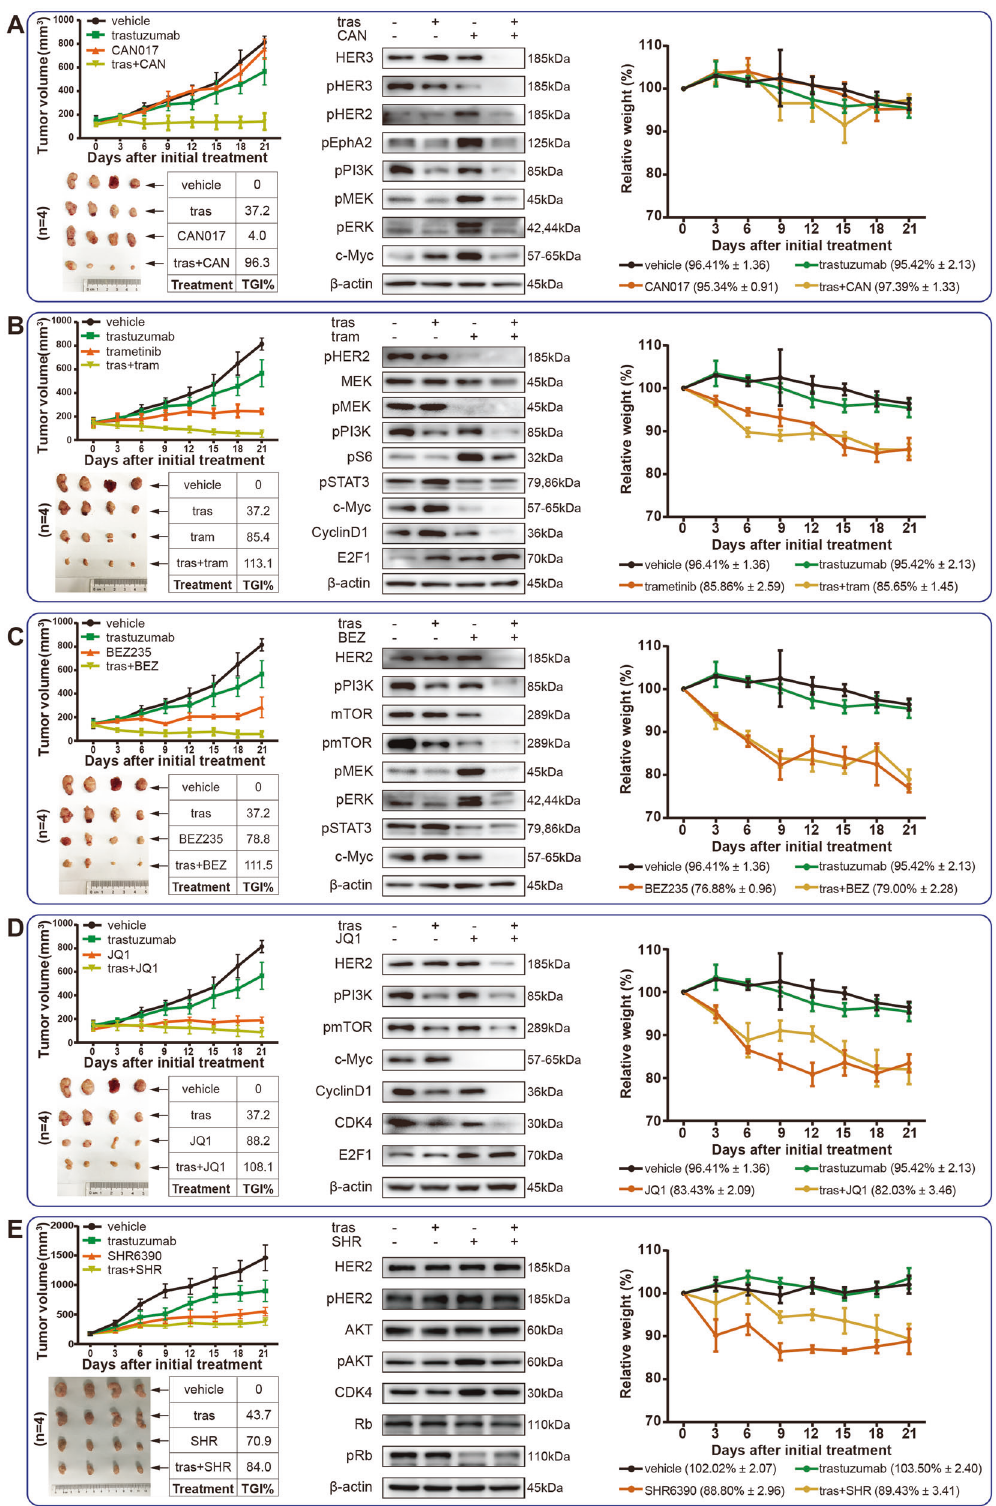
Fig. 7 The antitumor ef fi cacy of several inhibitors alone or in combination with Trastuzumab in Trastuzumab resistant model 176 R. Mice ( n = 4 per group) were treated with vehicle, Trastuzumab alone, inhibitors alone, and inhibitor combined with Trastuzumab for 21 days. ( A CAN017; B trametinib; C BEZ235; D JQ1; E SHR6390). Tumor volume was calculated and tumor growth curve was plotted, as well as the TGI and relative weight of the initial treatment. The related protein expressions were also displayed in each fi gure. TGI tumor growth inhibition, tras Trastuzumab, CAN CAN017, tram trametinib, BEZ BEZ235, SHR